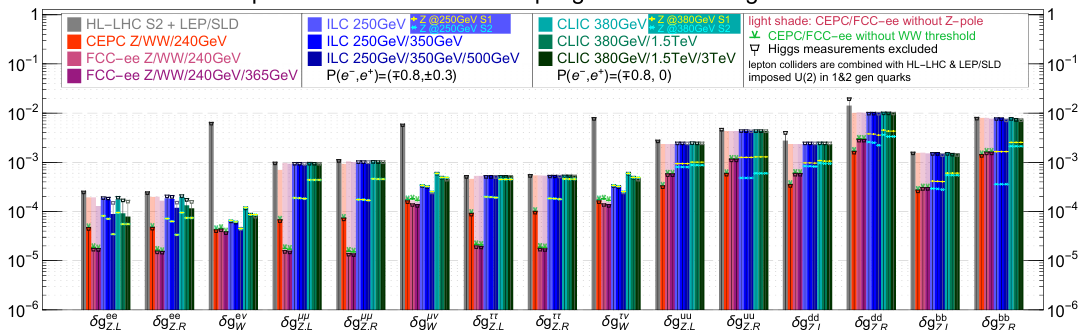
Figure 4 . Global one-sigma reach on electroweak couplings for the same scenarios as in (cid:12)gure 2. Higgs and triple-gauge coupling modi(cid:12)cations are marginalized over. Trapezoidal and green marks respectively indicate the prospects obtained with Higgs and WW threshold measurements excluded. The numerical results are reported in table 2.